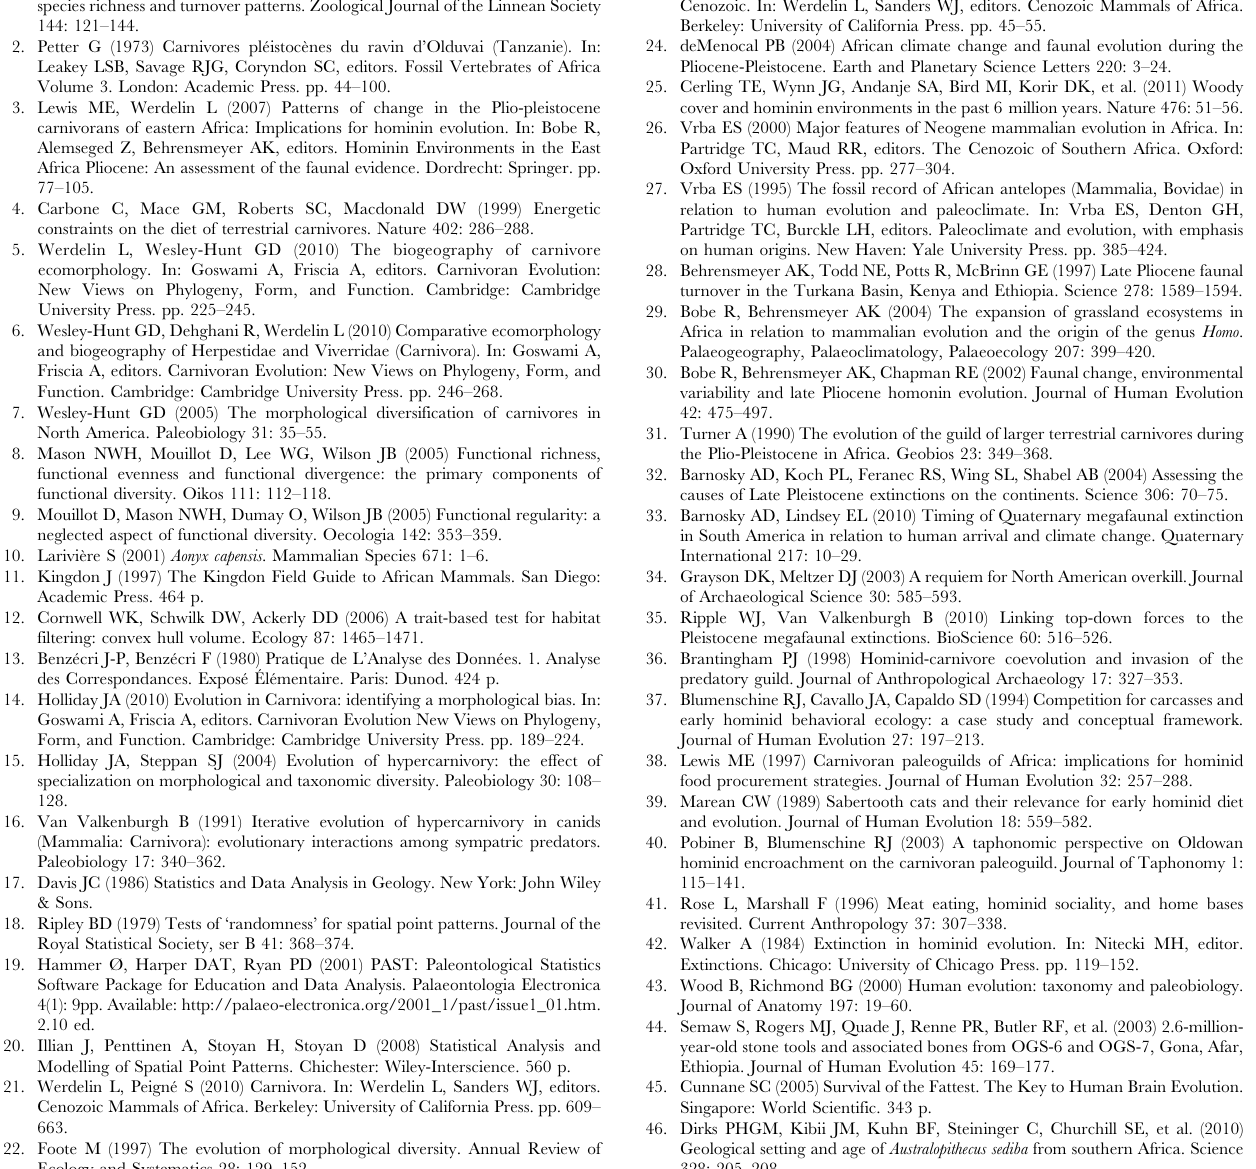
Table S1 Taxon coding used in the African extant/fossil analyses. Legend for Time slice column: 1: 3.5-3 Ma; 2: 3-